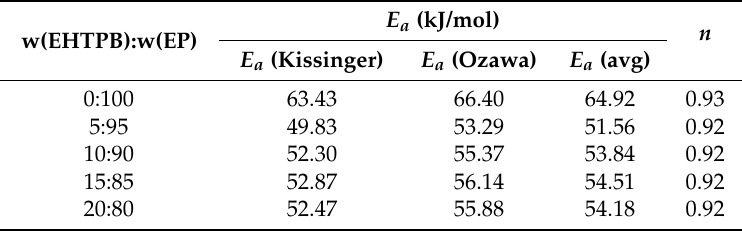
Figure 3. DSC curves of the curing reaction of the modified epoxy resin with different w(EHTPB)/w(EP) ratios: ( a ) w(EHTPB): w(EP) = 0:100; ( b ) w(EHTPB): w(EP) = 5:95; ( c ) w(EHTPB): w(EP) = 10:90; ( d ) w(EHTPB): w(EP) = 15:85; and ( e ) w(EHTPB): w(EP) = 20:80. Table 1. Curing kinetic parameters of modified epoxy resin with different w(EHTPB)/w(EP) ratios.